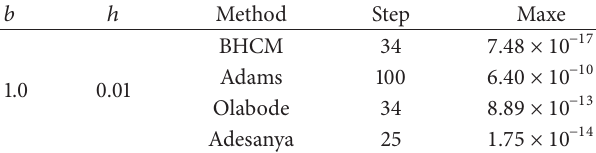
Table 3: Numerical results for Problem 3.